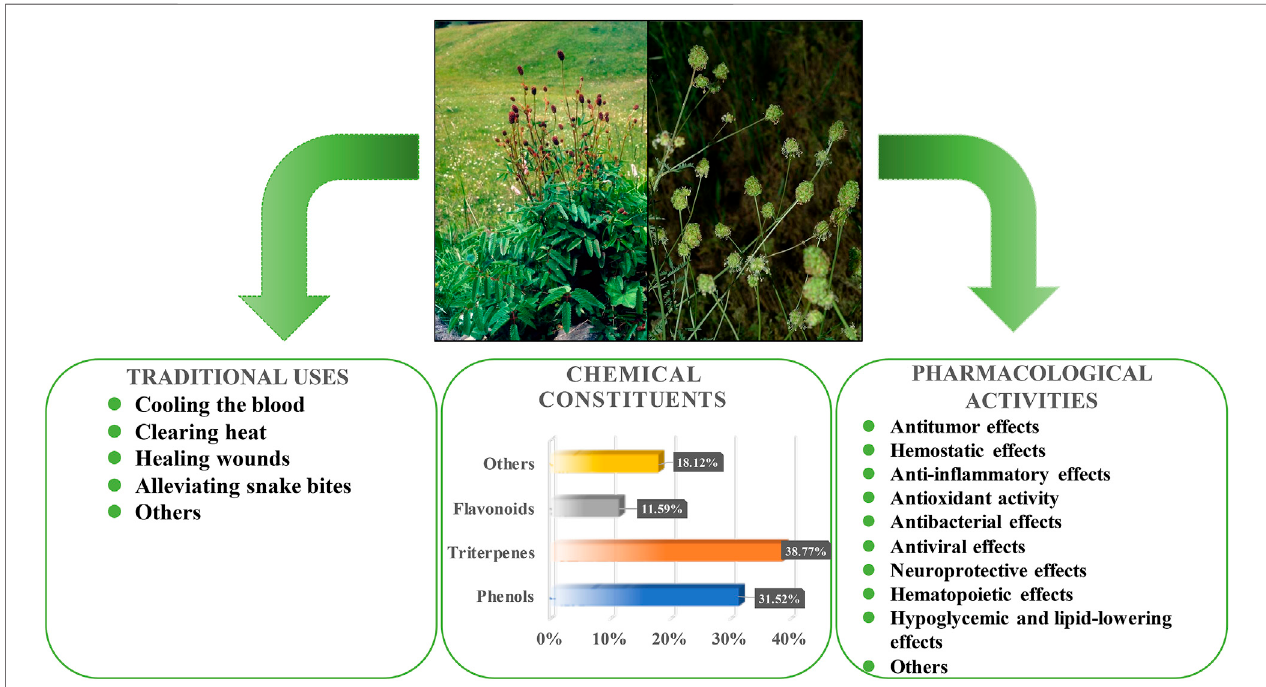
FIGURE 5 | Traditional applications, chemical compositions and pharmacological activities of S. of fi cinalis and S. minor.